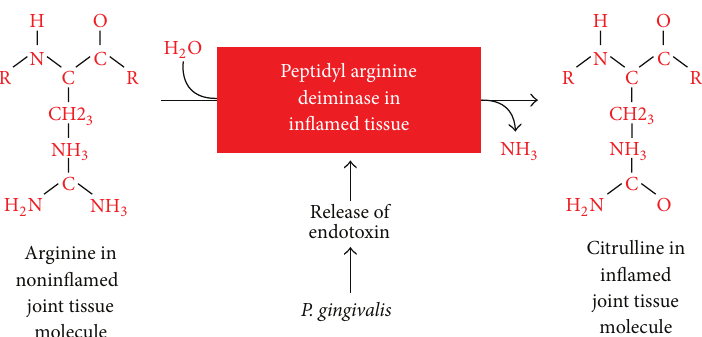
Figure 14: Potentiation by oral pathogens. Oral pathogens such as P. gingivalis can potentiate the deamination of arginine or formation of citrullinated proteins and peptides in joint and other tissues.